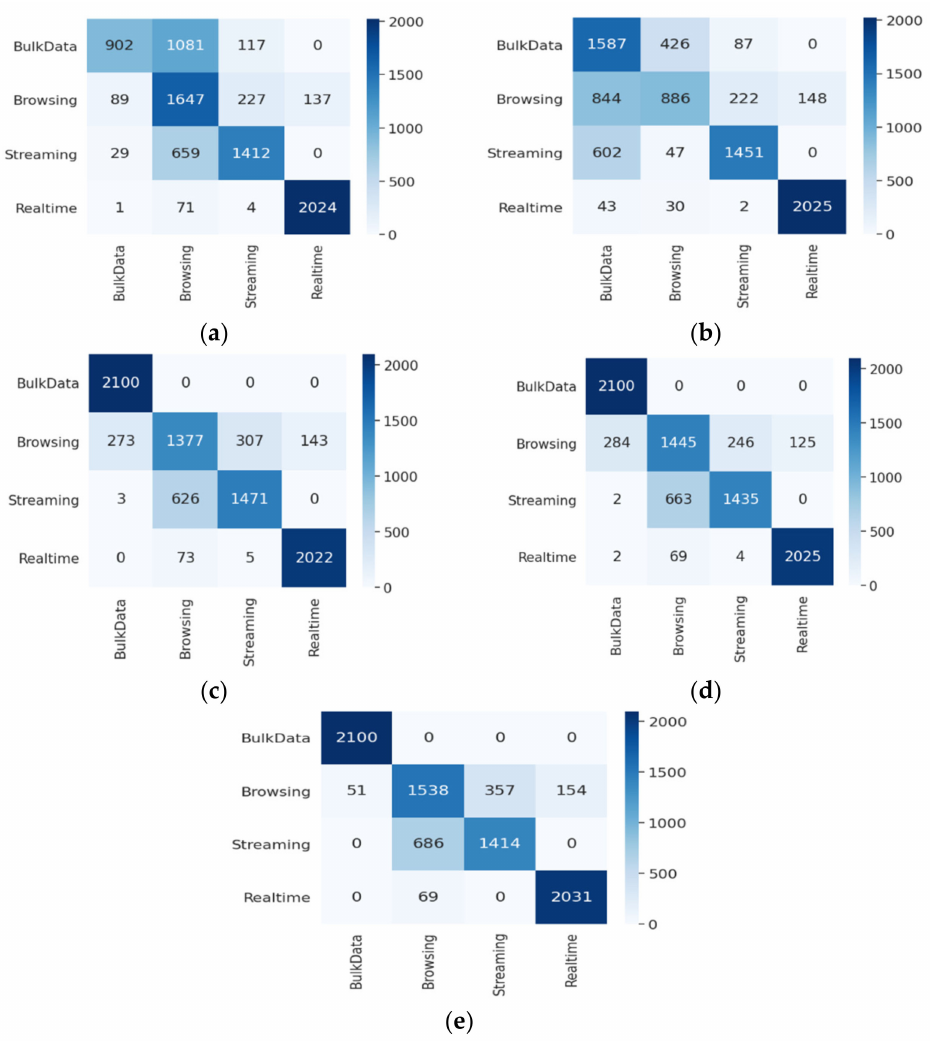
Figure 18. Confusion matrix of header feature selection and testing ( a ) Type I, ( b ) Type II, ( c ) Type III, ( d ) Type IV and ( e ) Type V.